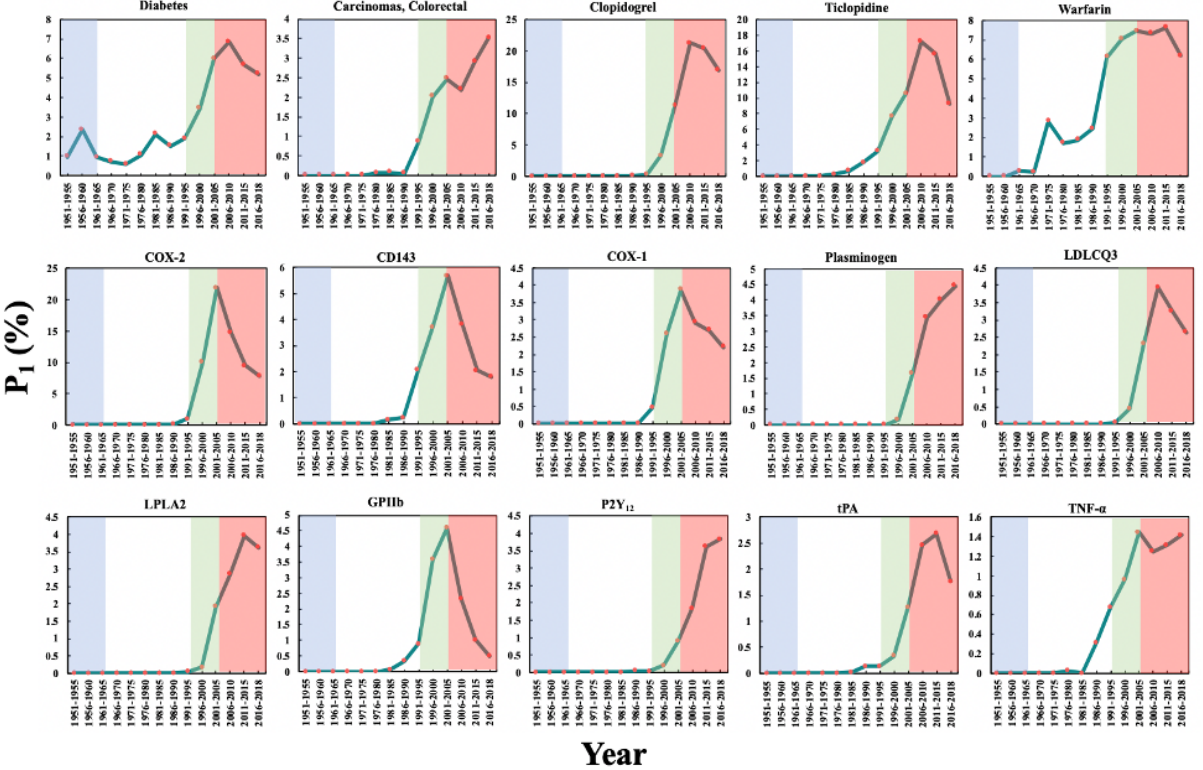
Figure 8. The Popularity Index (P 1 ) of the biomedical entities on repurposing aspirin for other diseases over time. The background colors show the 4 phases of aspirin